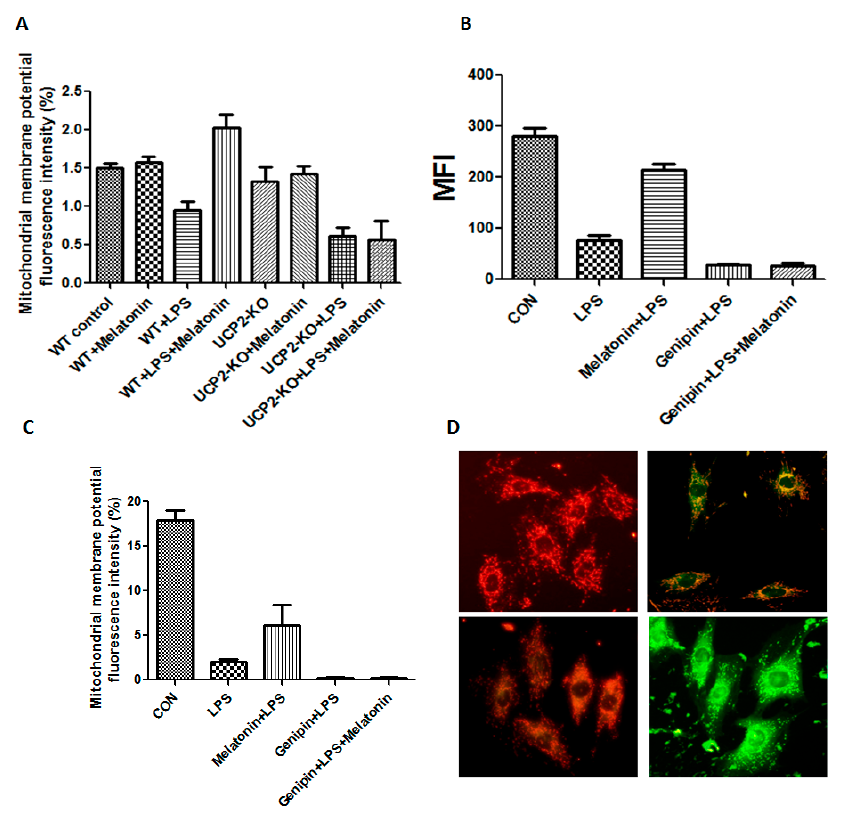
Figure 4. Effect on mitochondrial membrane potential and permeability transition pore. Panel ( A ): Effect on mitochondrial membrane potential in the heart tissues of the animals. Vertical axis: Mitochondrial membrane potential as expressed by fluorescence intensity (%); horizontal axis: groups of animals. Panel ( B ): Effect on mitochondrial permeability transition pore in the cultured AC16 cells. Vertical axis: Mitochondrial permeability transition pore (MFI); horizontal axis: Treatment of the cells. Panel ( C ): Effect on mitochondrial membrane potential in cultured AC16 cells. Vertical axis: mitochondrial membrane potential as expressed by fluorescence intensity (%); horizontal axis: Groups of animals. Panel ( D ): The fluorescence changes in mitochondrial membrane potential. Left upper showed control, left lower showed LPS + melatonin, right upper showed LPS group, right lower showed LPS + genipin group.